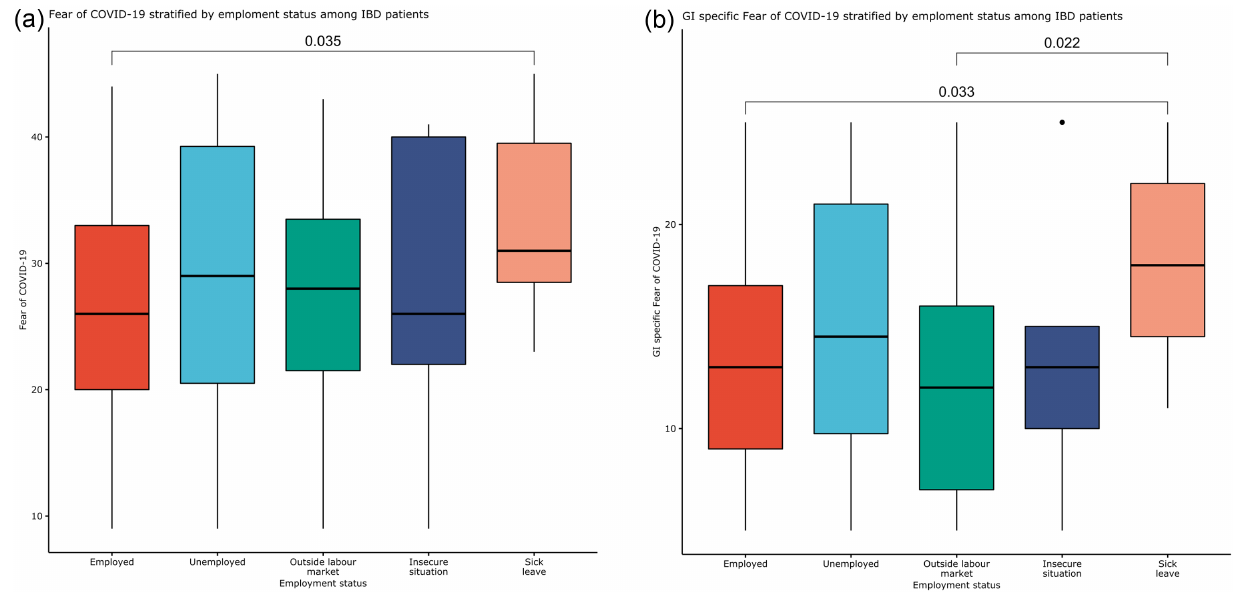
Figure 1. (A-B.) Fear of COVID-19 stratified by employment status among IBD patients (A) and GI-specific fear of COVID-19 stratified by employment status among IBD patients (B). IBD, inflammatory bowel disease; COVID-19, coronavirus disease 19; GI,